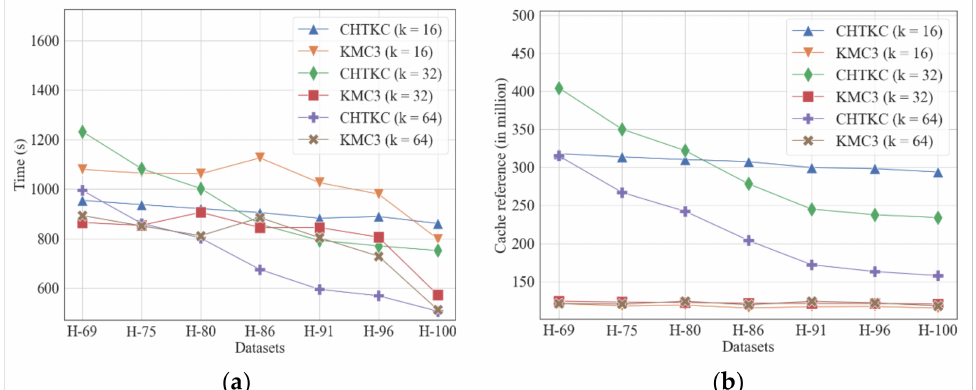
Figure 6. Comparison of KMC3 and CHTKC with various sequencing errors. ( a ) running time; ( b ) cache